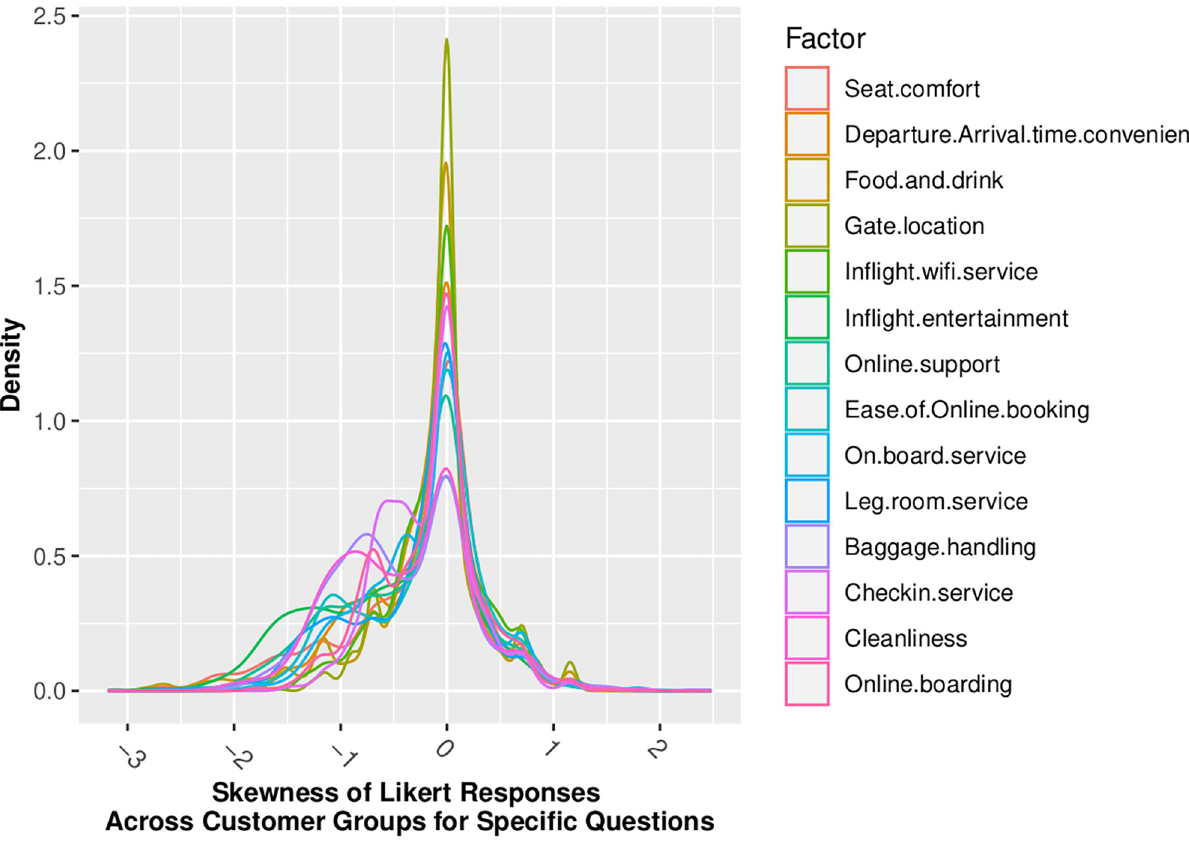
Fig 4. Skewness of likert responses by